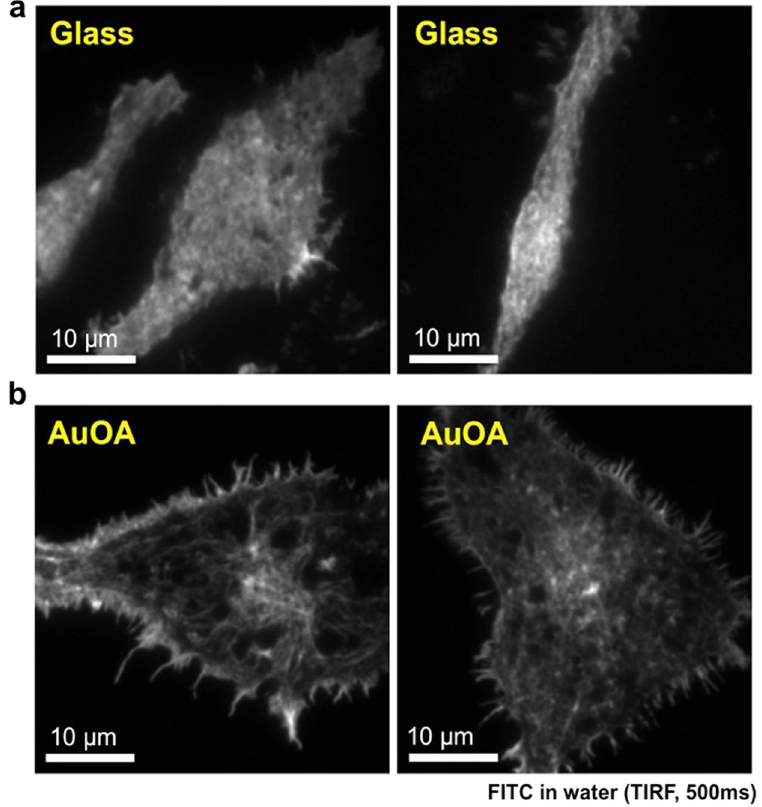
Figure 3. Fluorescence images of FITC-labeled actin filaments in the RBL-2H3 cells. The images were taken on glass ( a ) and on the AuOA sheet ( b ) in aqueous medium. The incubation time for the cell adhesion was overnight. The incident light was 488 nm in wavelength, and the intensity was 5 mW. The incident angle was set at the maximum value ( < 78° when the critical angle of TIR was 61.4°). The exposure time was 500 msec for all